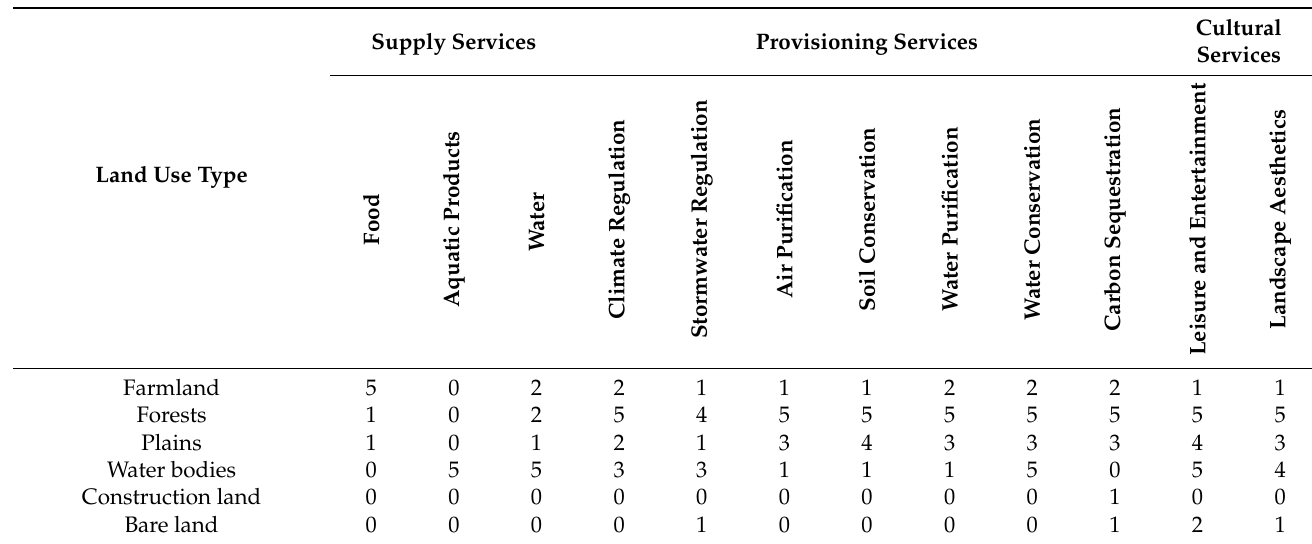
Table 1. Huai River Basin ecosystem services supply matrix.